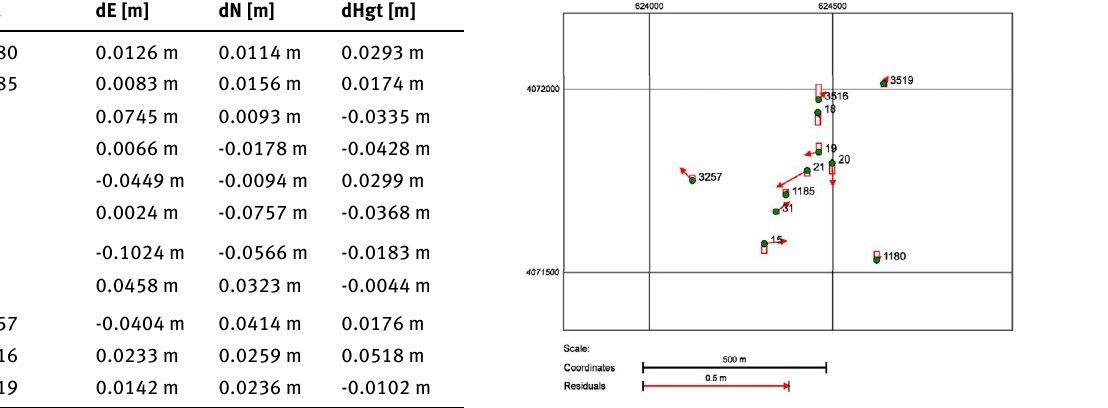
Table 2. Graphical overview of the Twostep transformation residuals © ÖAW/IKAnt (M. Hernández Cordero).